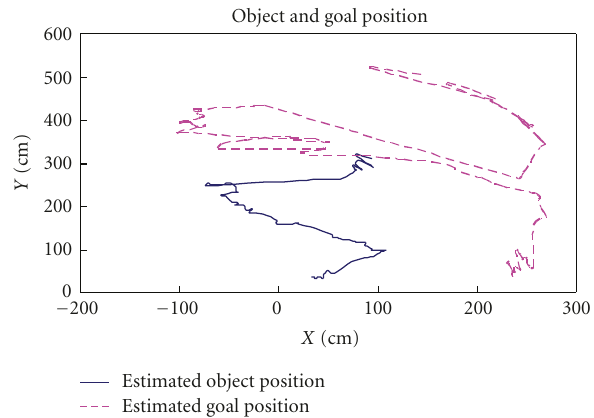
Figure 14: The estimated object position and goal position by the proposed algorithm. Table 4: Comparisons of average tracking errors in cm among PF- SF and RBPF-SF. Total std.